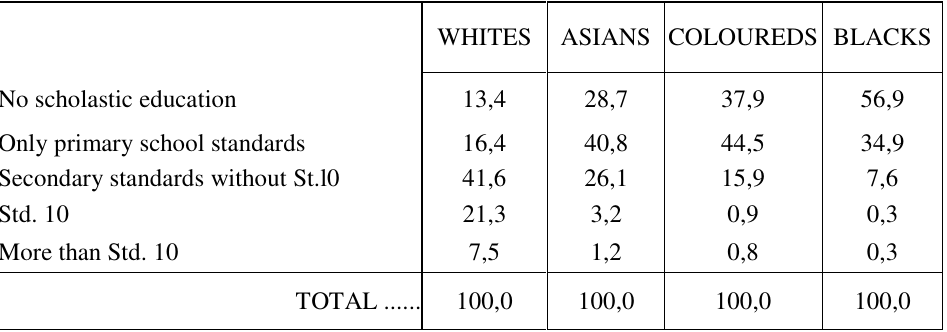
QUALIFICATIONS OF TOTAL S.A. POPULATION ACCORDING TO 1970-CENSUS (%'s) WHITES ASIANS COLOUREDS BLACKS No scholastic education 13,4